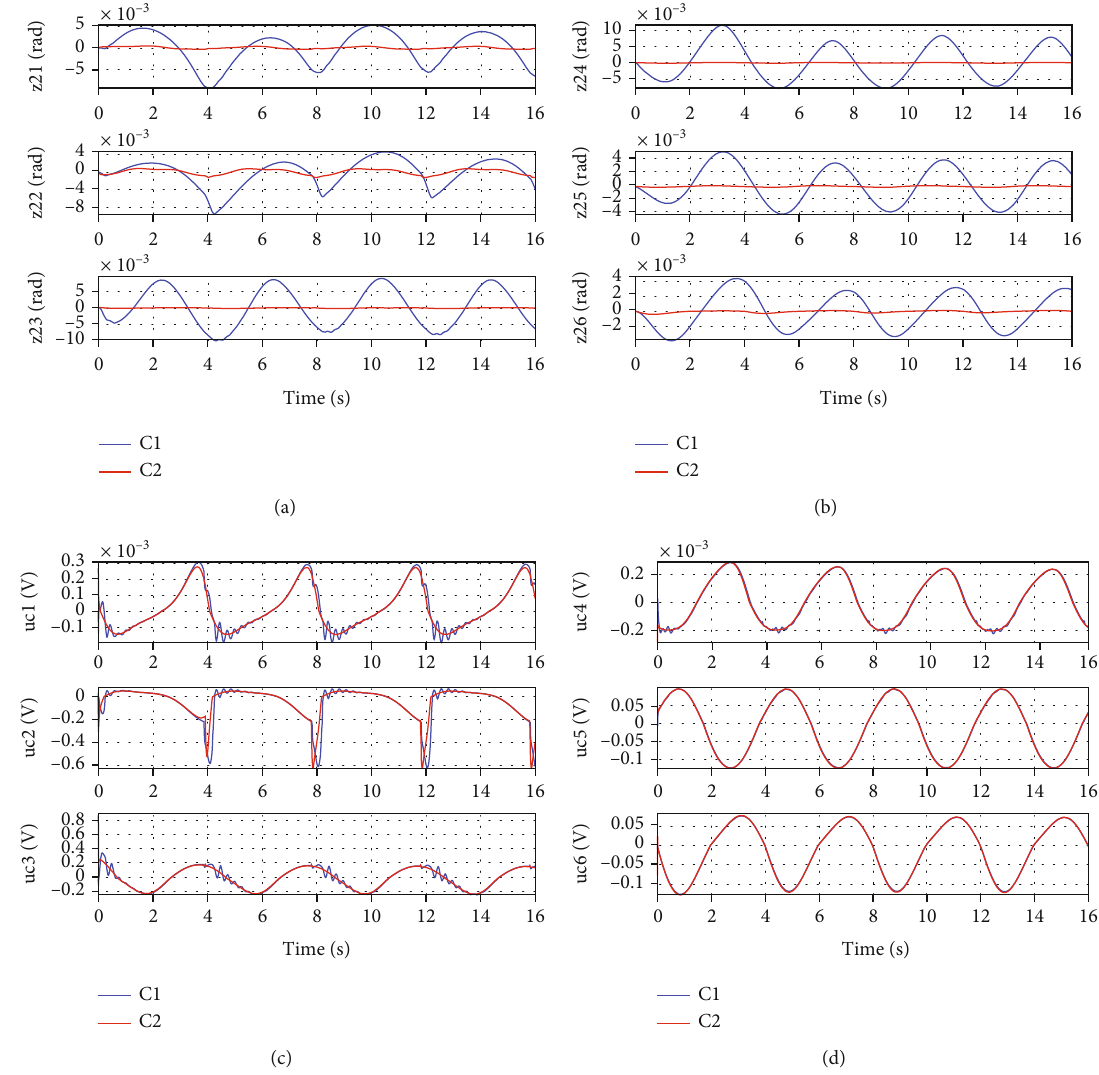
Figure 5: Simulation results of left leg support for Set1: (a) motion tracking error for the left leg joints, (b) motion tracking error for the right leg joints, (c) control input for the left leg joints, and (d) control input for the right leg